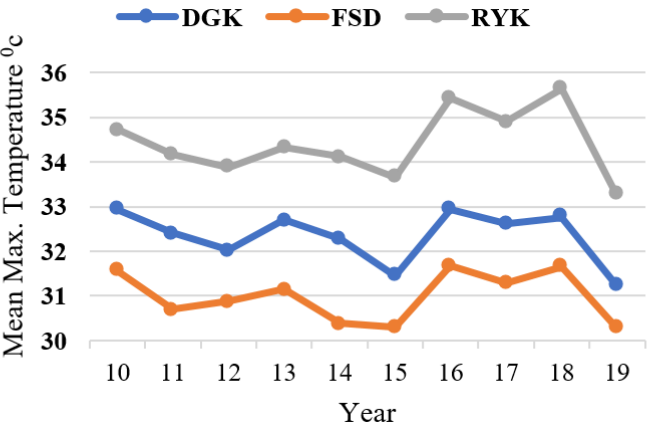
Figure 4. Maximum temperature (mean) of study locations (2010–2019).